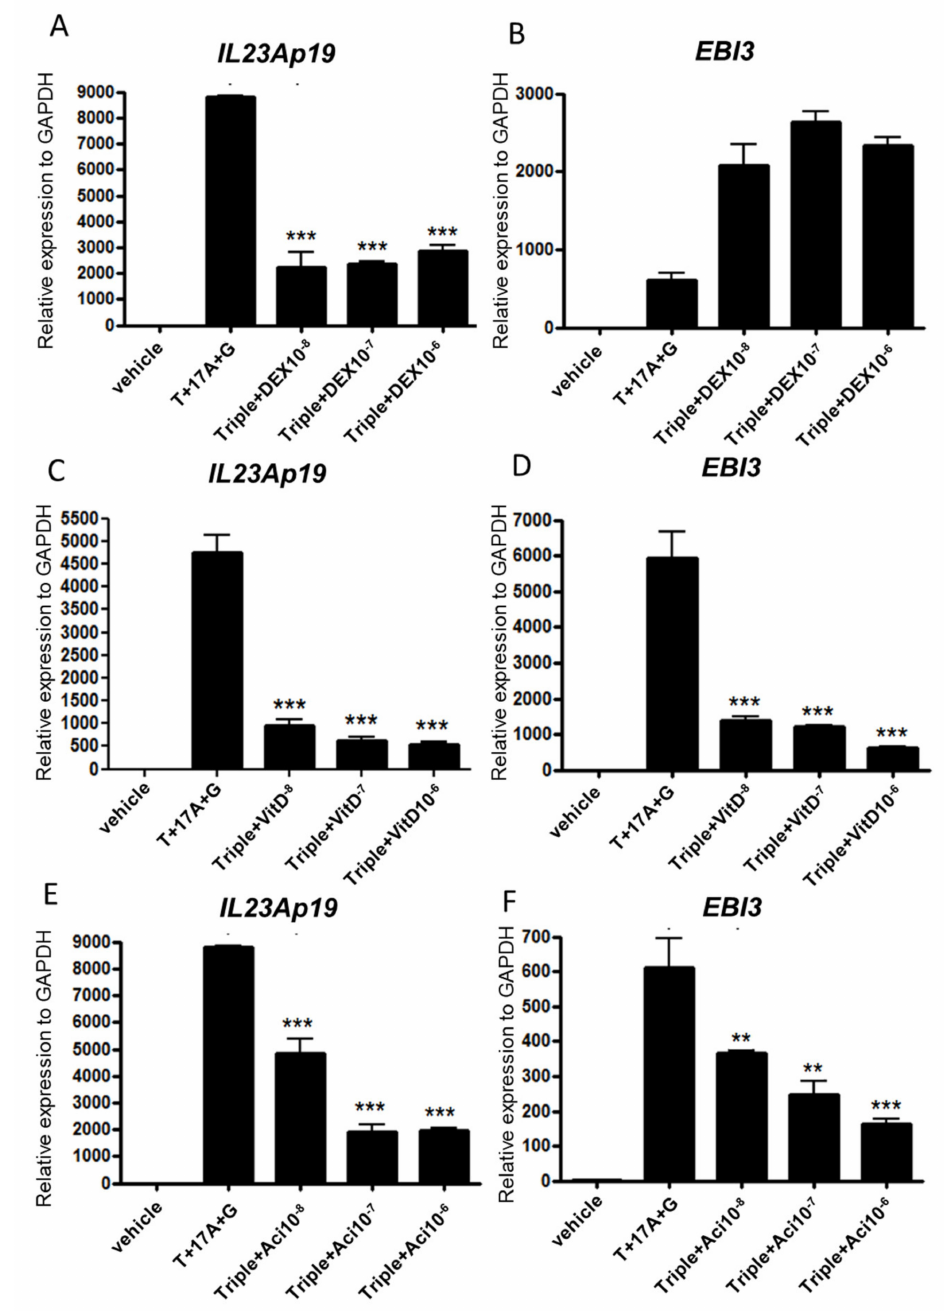
Figure 3. Topical treatment by dexamethasone, vitamin D3, and acitretin suppress IL23Ap19 and EBI3 expressions in NHEKs. Normal human epidermal keratinocytes (NHEKs) were stimulated with the triple combination of TNF- α (50 ng/mL), IL-17A (50 ng/mL), and IFN- γ (50 ng/mL), and simultaneously treated with ( A , B ) dexamethasone (10-8,10-7, or 10-6 M), ( C , D ) 1,25(OH)2 vitamin D3 (10-8,10-7, or 10-6 M), or ( E , F ) acitretin (10-8,10-7, or 10-6 M) for 24 h. The relative mRNA expressions of IL23Ap19 and EBI3 to GAPDH were analyzed with quantitative real-time PCR (qPCR). ** p < 0.01, *** p < 0.001. T, TNF- α ; 17A, IL-17A; G, IFN- γ ; Triple, T+17A+G; DEX, dexamethasone; VitD, 1,25(OH)2 vitamin D3; Aci,